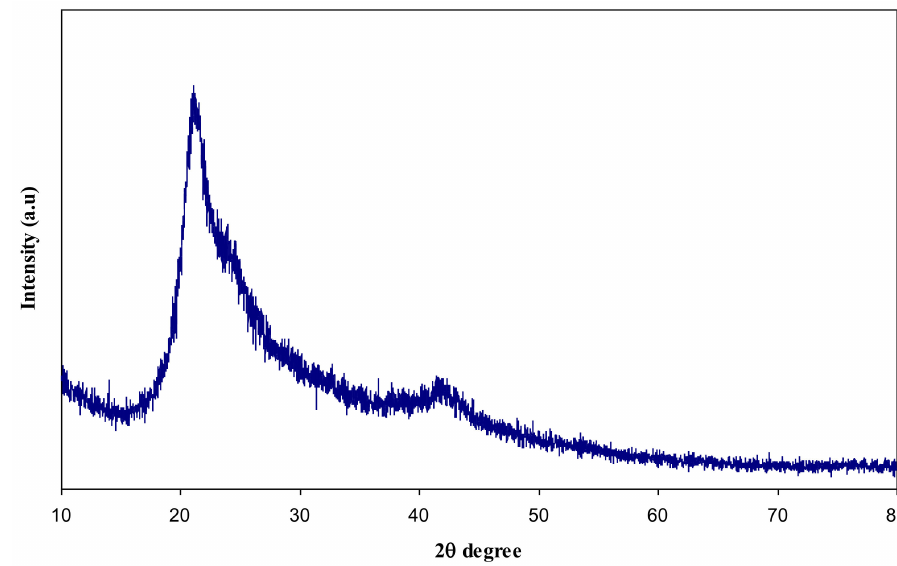
Figure 4. XRD pattern for pure PVA solid film.